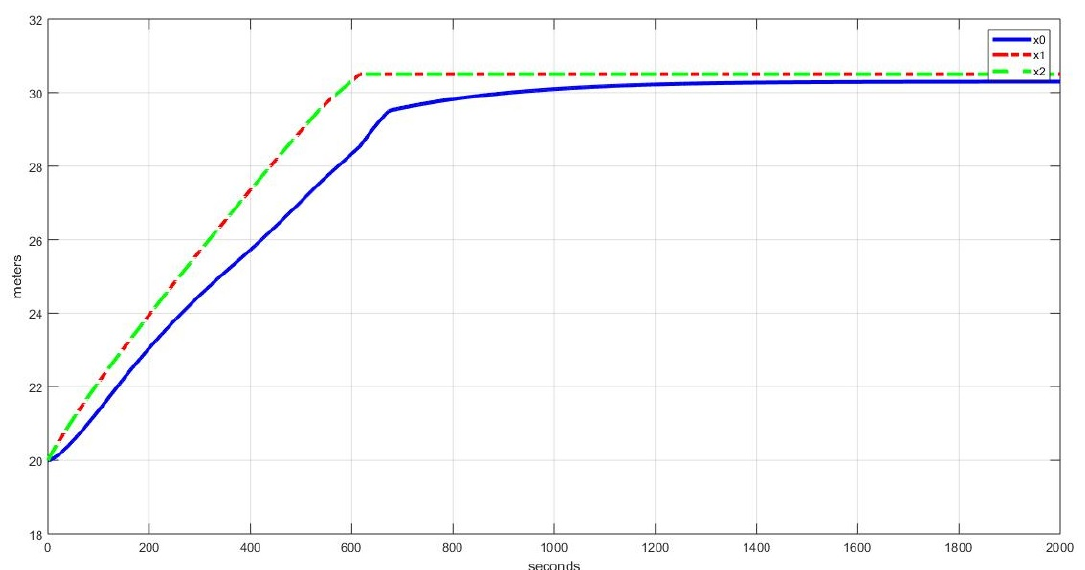
Figure 7. Pond levels (0, 1, and 2) in normal operation at the desired power of 1.65 MW.